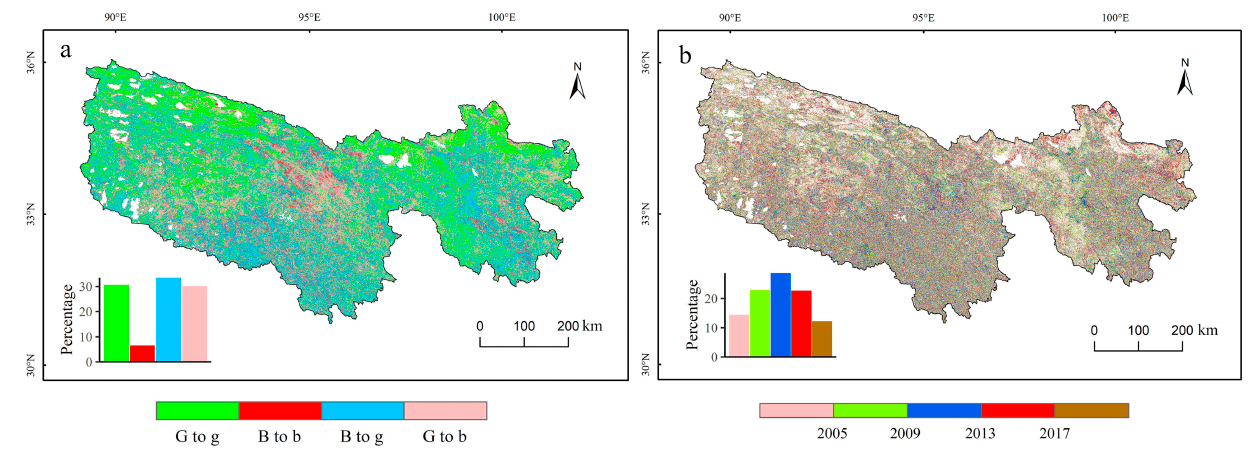
Figure 6. Spatial distributions of EVI trends ( a ) and the timing of change points derived using the EEMD method ( b ).